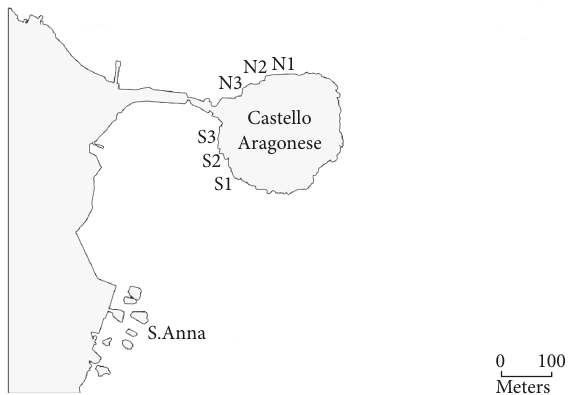
Figure 1: Ischia island sampling sites: Castello Aragonese with acidified (S3, S2, N3, N2) and control (S1, N1) stations and the control site at Sant’Anna